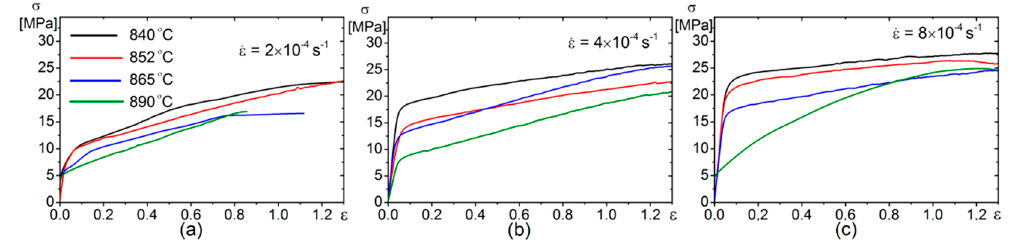
Figure 1. The true stress–strain curves of the tested alloy at various temperatures and various